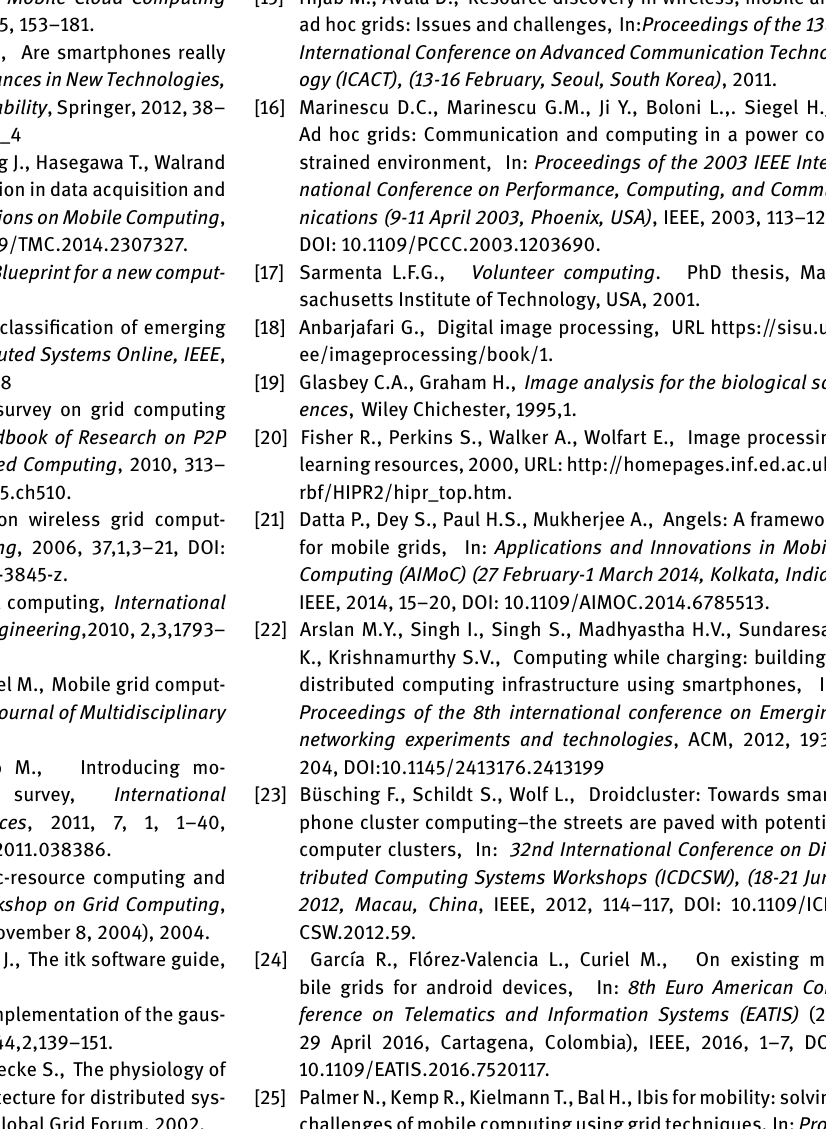
art and future, Enabling Real-Time Mobile Cloud Computing through Emerging Technologies , 2015,